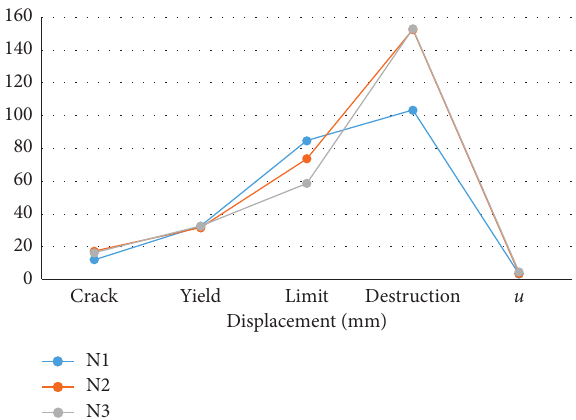
Figure 3: Displacement and ductility coefficient of frame joints.